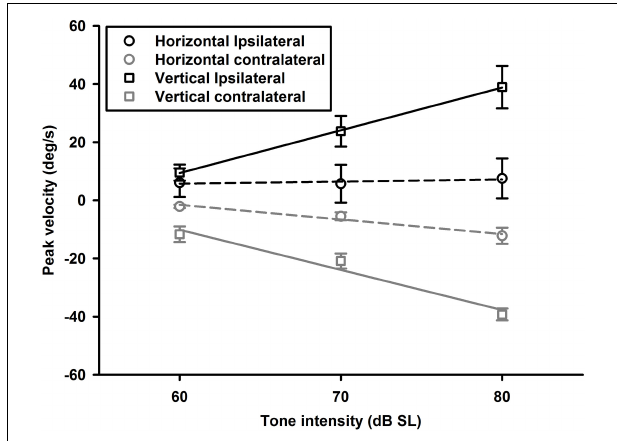
FIGURE 12 | Averaged peak velocities of 1,500 Hz tone burst-evoked horizontal (circles) and vertical (squares) eye movements as a function of tone intensity. Black lines and symbols are for contralateral ear stimulation, and gray lines and symbols are for ipsilateral ear